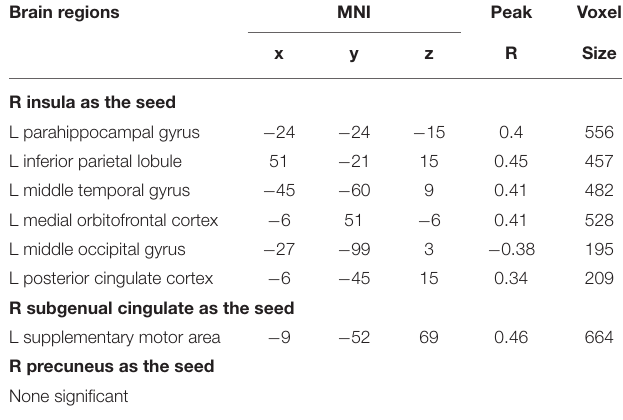
TABLE 2 | Brain regions in functional connectivity strengths with seeds were significantly related to PES. Brain regions MNI Peak